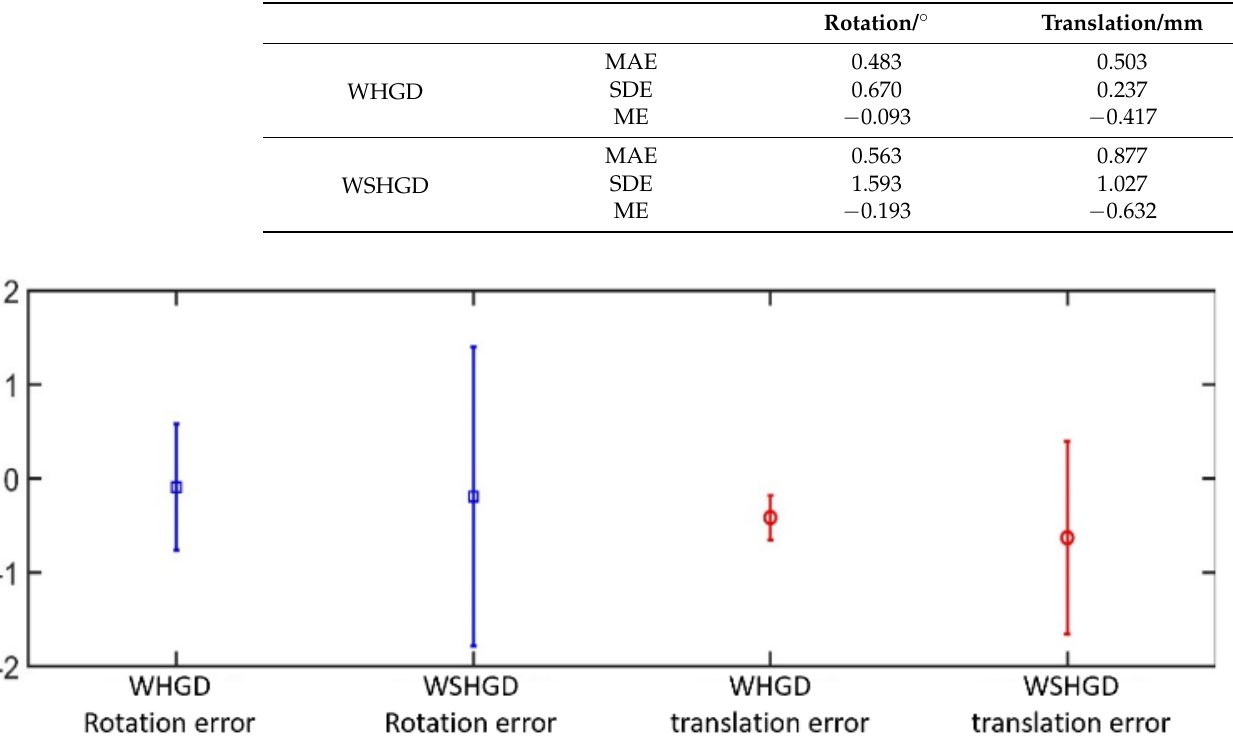
Figure 7. Registration error and mean values of the weighted histogram of gradient directions (WHGD) and the weighted spatial histogram of gradient directions (WSHGD). Table 2. Registration results of the WSHGD and WHGD.